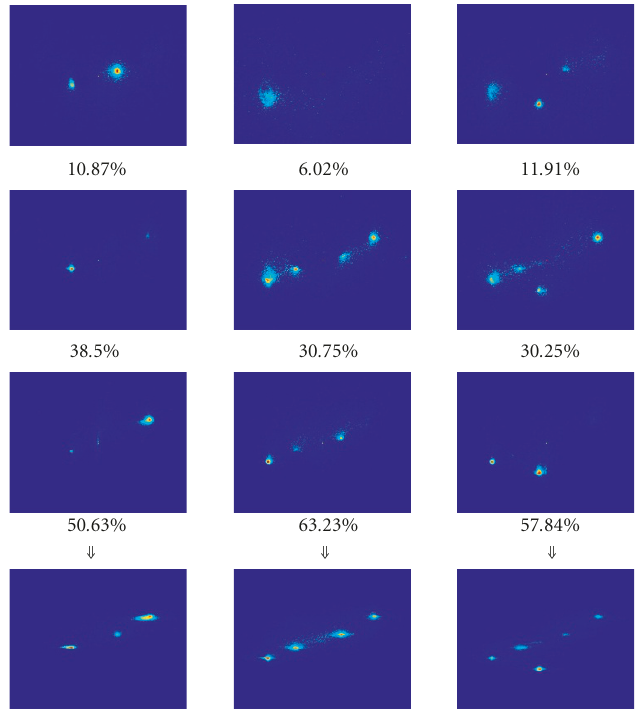
Figure 7: Histograms for 6 echoic mixtures of 1 source arriving on 3 paths (a), 2 sources arriving on 2 paths each (b), and 2 sources arriving on 2 paths and 3 paths, respectively, (c). The average percentage power associated with each histogram is also given as a label to each component histogram. Each plot has an x -axis with units − 2 . 5 ≤ (cid:27) δ ≤ 2 . 5 samples and a y -axis with units − 2 . 5 ≤ log( (cid:27) α ) ≤ 2 .